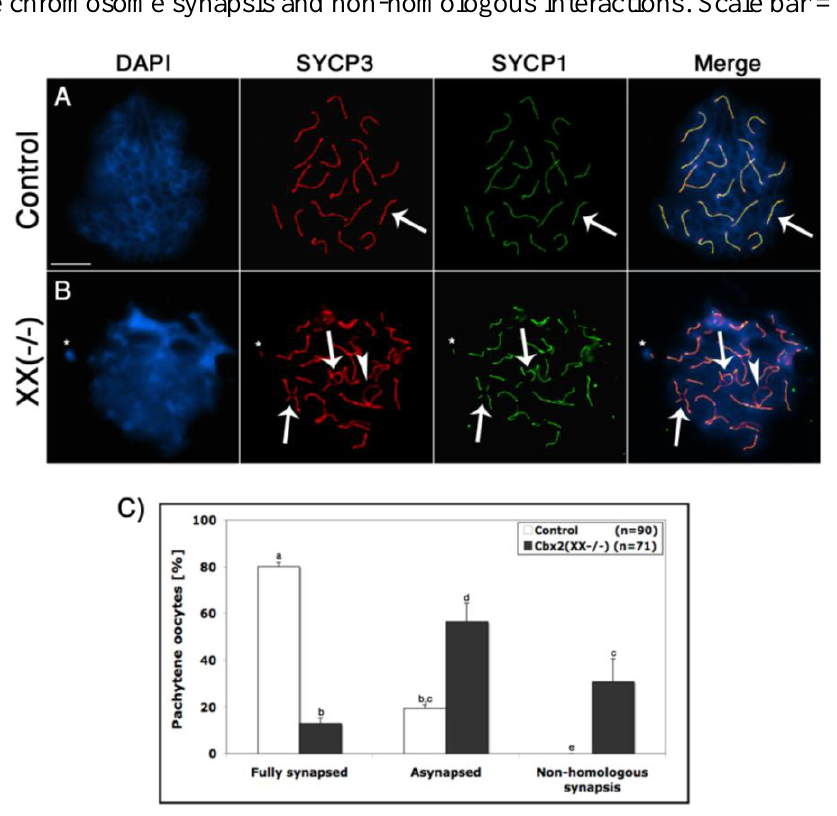
Figure 3. Abnormal synapsis and non-homologous chromosome interactions in Cbx2 (XX−/−) mutant oocytes. ( A ) Chromosome synapsis (arrow) in control oocytes at the pachytene stage showing complete co-localization of lateral (SYCP3, red) and central (SYCP1, green) elements of the synaptonemal complex; ( B ) Stage-matched Cbx2 (XX−/−) oocyte presenting abnormal synapsis (arrowhead), non-homologous chromosome interactions between two partially synapsed bivalents (arrows) as well as structural damage in the form of prominent chromosome breaks (asterisk). DNA is shown in blue; ( C ) Proportions of pachytene stage oocytes obtained from control and mutant fetuses on day 18.5 pc showing incomplete chromosome synapsis and non-homologous interactions. Scale bar = 10 